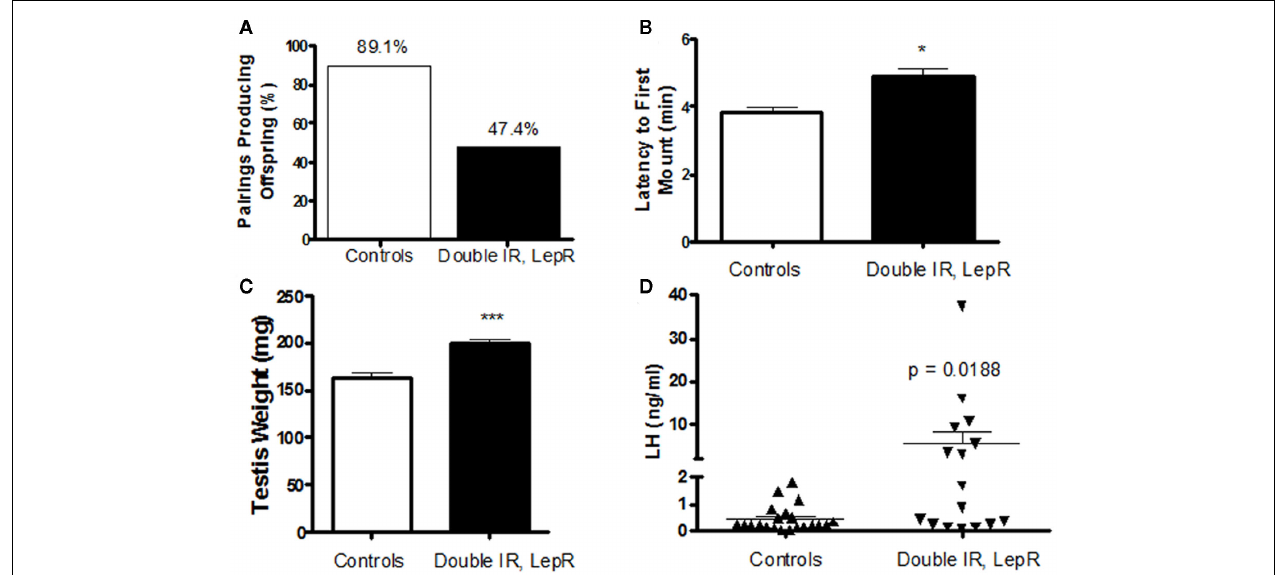
FIGURE 1 | Reproductive phenotype of 4-month-old IR, LepR POMC mice. (A) Male mice lacking insulin and leptin receptors in POMC neurons were paired with genetically normal control females and the number of pairings producing pups were quantified. (B) The amount of time before experimental and control males attempted to mount a novel control female was